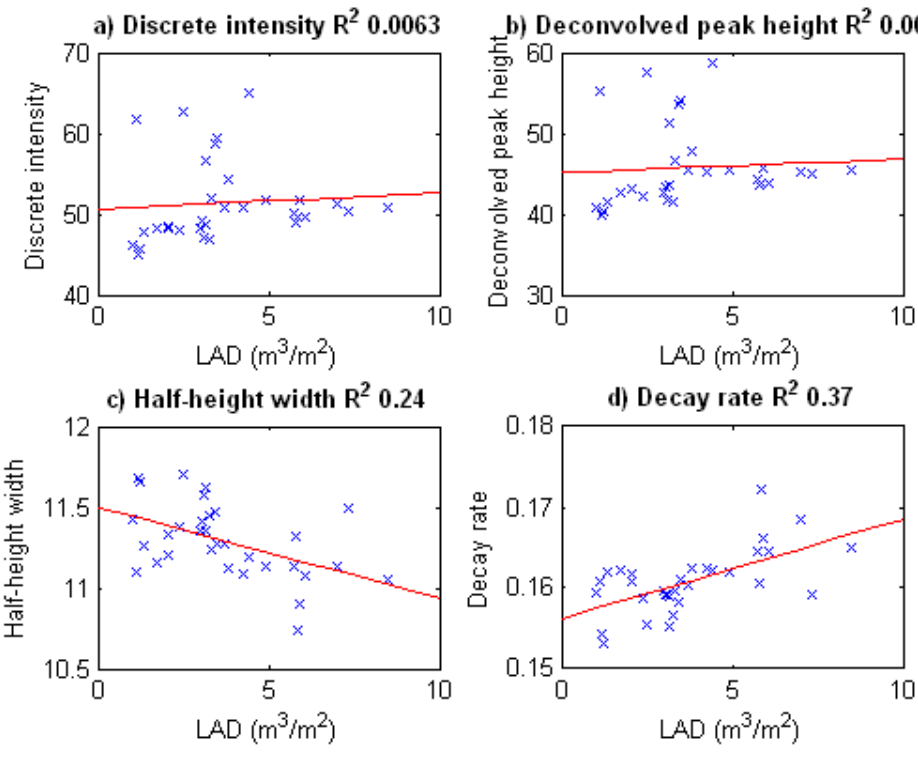
Figure 11. Comparison of the average value in a set of 1,600 m 2 × 2 m sample plots for ( a ) intensity of discrete LiDAR returns, ( b ) peak height of deconvolved waveform LiDAR returns, ( c ) half-height width of deconvolved waveform LiDAR and ( d ) exponential decay rate of deconvolved waveform LiDAR returns, relative to the average field-measured leaf area density over the corresponding height band above